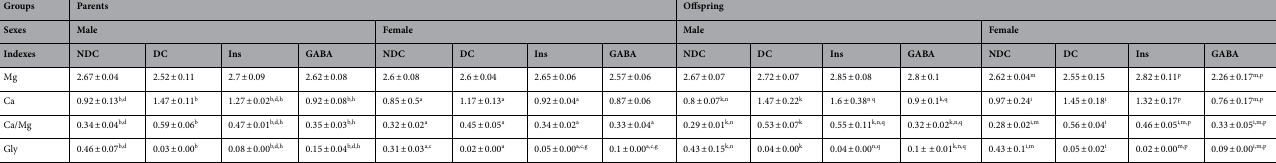
Table 4. Comparison of liver biochemical factors in male and female groups of non-diabetic control group (NDC) was fed with normal diet, diabetic control group received high-fat diet for 3 months and 35 mg/kg STZ (DC), diabetic animals treated with 1.5 gr/kg GABA via IP injection (GABA) and diabetic animals treated with insulin (2.5 U/kg twice per day) (Ins) and their offspring. (3 rats in offspring of GABA groups and 5 rats in other group, data are expressed as mean ± S.E.M). Mg magnesium, Ca calcium, Gly Glycogen. a Significant difference in liver Mg, Ca, Mg/Ca and Gly levels between female DC group and other female groups (Ca: ( P < 0.05); Ca/Mg and Gly: ( P < 0.01)). b Significant difference in liver Mg, Ca, Mg/Ca and Gly levels between male DC group and other male groups (Ca: ( P < 0.05); Ca/Mg and Gly: ( P < 0.01)). c Significant difference in liver Mg, Ca, Mg/Ca and Gly levels between female NDC group and other female groups (Ca: ( P < 0.05); Gly: ( P < 0.001)). d Significant difference in liver Mg, Ca, Mg/Ca and Gly levels between male NDC group and other male groups (Ca: ( P < 0.05); Ca/Mg: ( P < 0.01); Gly: ( P < 0.001)). g Significant difference in liver Mg, Ca, Mg/Ca and Gly levels between female GABA group and female Ins group ( P < 0.05). h Significant difference in liver Mg, Ca, Mg/Ca and Gly levels between male GABA group and male Ins group (Ca: ( P < 0.001); Ca/Mg: ( P < 0.01); Gly: ( P < 0.05)). i Significant difference in liver Mg, Ca, Mg/Ca and Gly levels between female offspring DC group and other female offspring groups (Ca: ( P < 0.05); Ca/Mg: ( P < 0.001); Gly: ( P < 0.01)). k Significant difference in liver Mg, Ca, Mg/Ca and Gly levels between male offspring DC group and other male offspring groups ( P < 0.01). m Significant difference in liver Mg, Ca, Mg/Ca and Gly levels between female offspring NDC group and other female offspring groups (Mg and Gly: ( P < 0.01); Ca/Mg: ( P < 0.001)). n Significant difference in liver Mg, Ca, Mg/Ca and Gly levels between male offspring NDC group and other male offspring groups (Ca: ( P < 0.05); Ca/Mg and Gly: ( P < 0.001)). p Significant difference in liver Mg, Ca, Mg/Ca and Gly levels between female offspring GABA group and female offspring Ins group (Mg and Ca: ( P < 0.01); Ca/Mg and Gly: ( P < 0.001)). q Significant difference in liver Mg, Ca, Mg/Ca and Gly levels between male offspring GABA group and male offspring Ins group (Ca: ( P < 0.05); Ca/Mg and Gly: ( P < 0.001)).